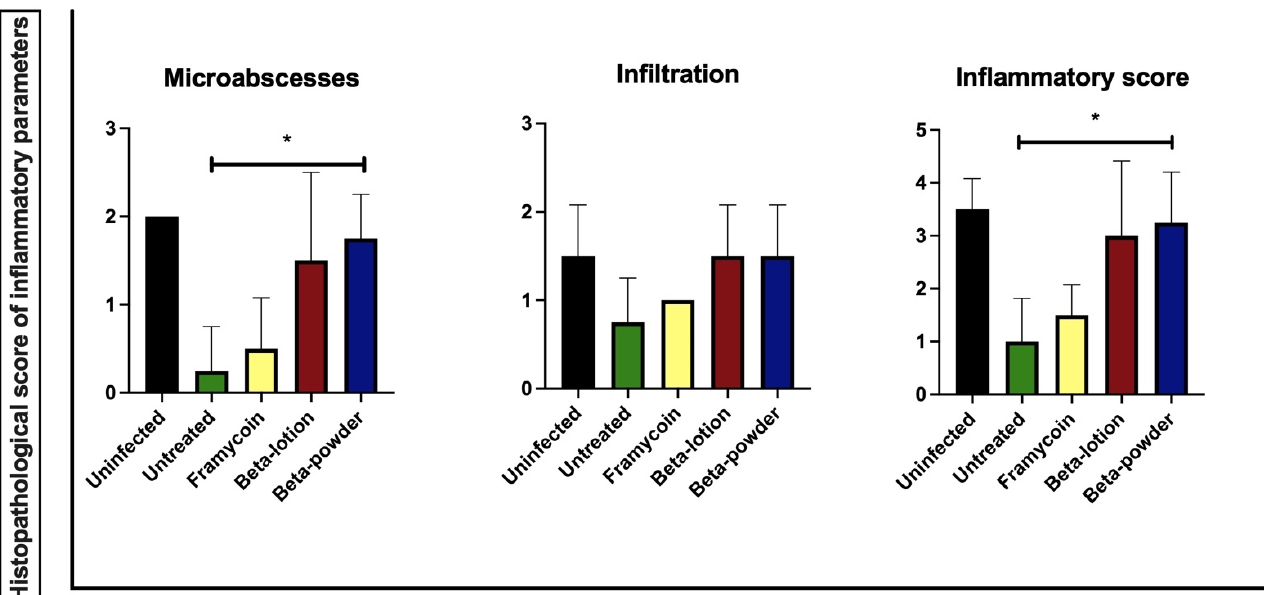
Figure 4. The wound healing evaluation. Individual wound characteristics were assigned numeri- cal scores and the analysis for day 10 is shown. Statistical analysis was performed with the non- parametric Kruskal–Wallis test and the multiple comparison test (* p < 0.05 and ** p < 0.01). While the color characteristics alone showed no significant differences between the individual treatments, the application of beta-acids exhibited a clear positive effect on the overall healing score. Beta-acids in powder form show marked and significant differences when compared to the untreated and Framycoin-treated wounds. Interestingly, the over-